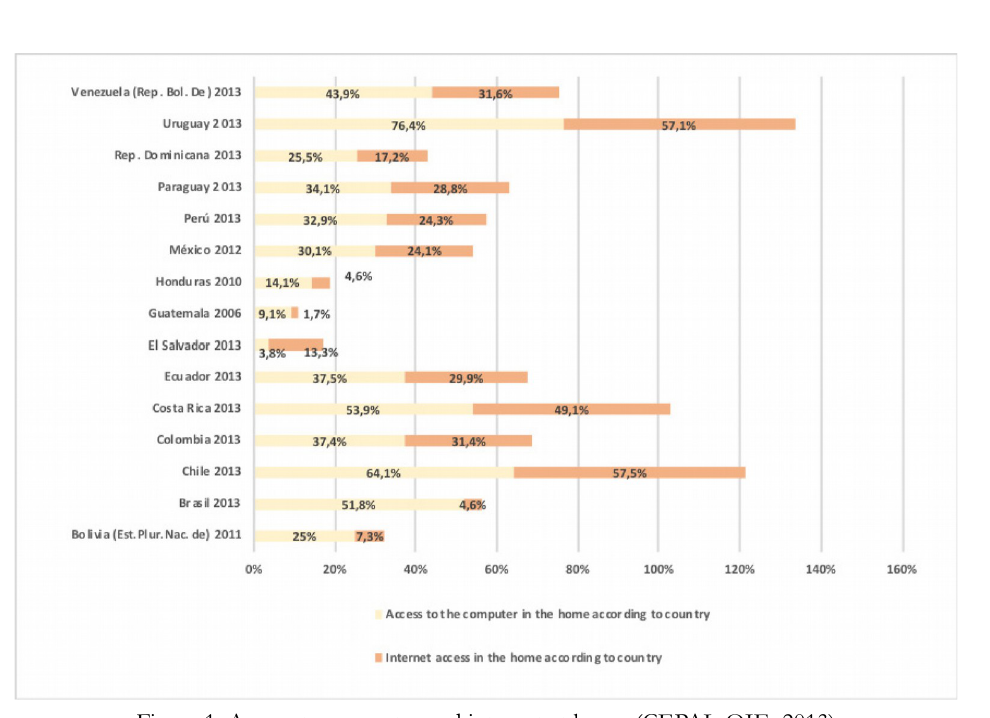
Figure 1. Access to computer and internet at home (CEPAL-OIE, 2013)